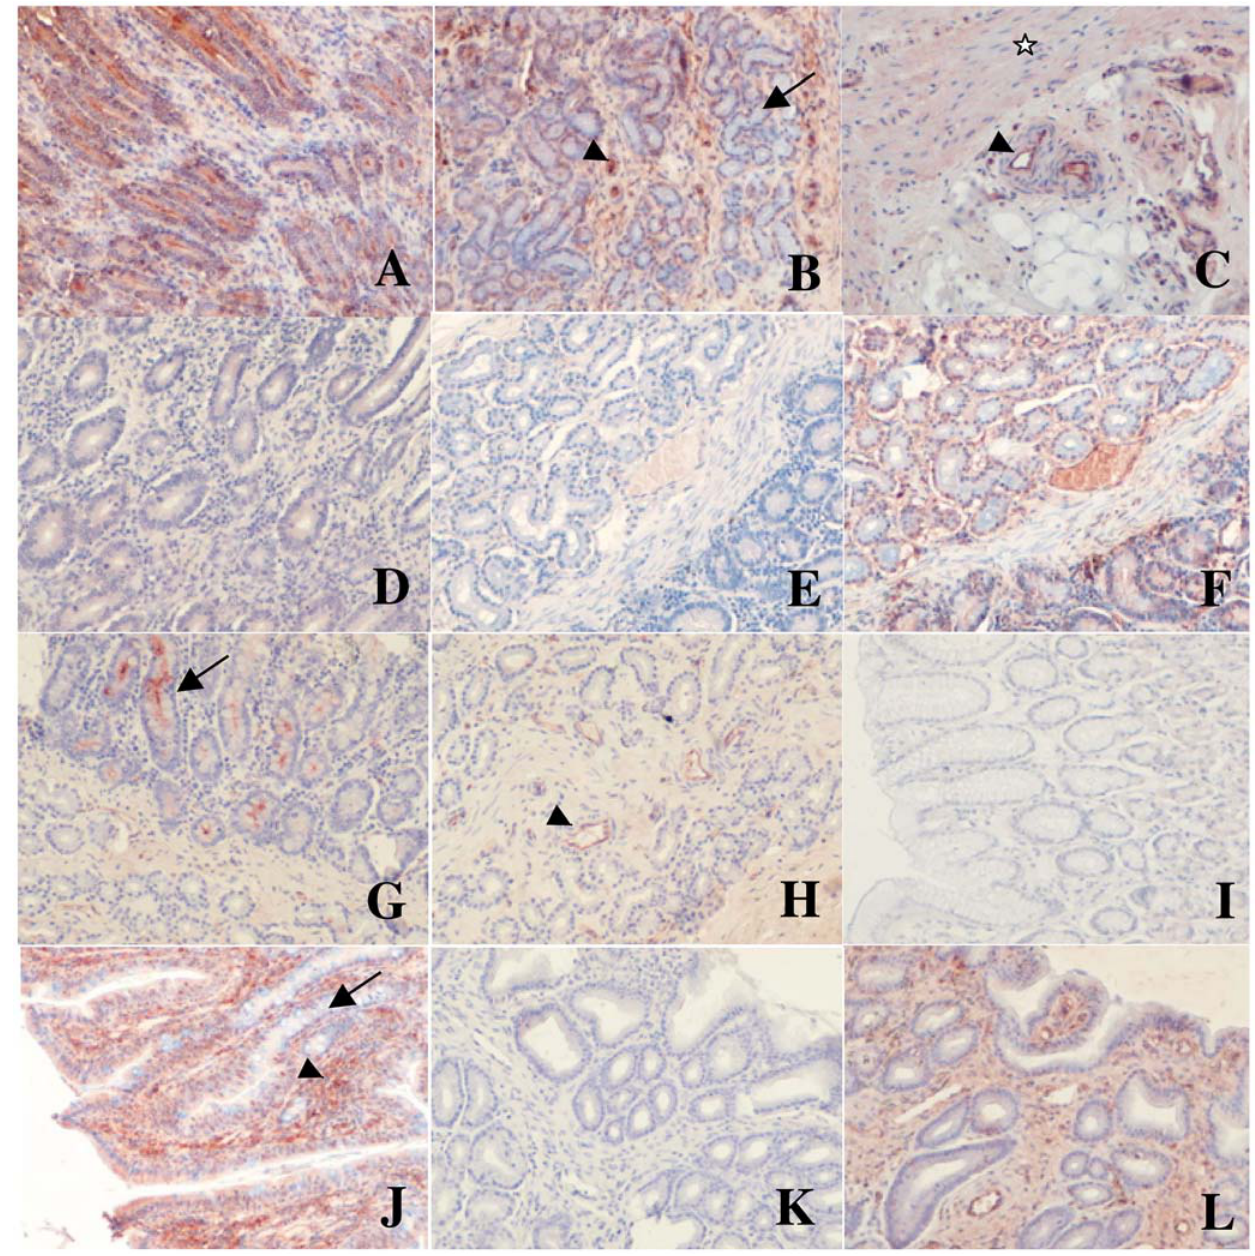
Figure 1. Analysis of rNB2 VLPs binding and of their ligand expression by immunohistology. VLPs at 1 m g/ml were incubated on tissue sections and detected as described in the Materials and Methods section. Binding of rNB2 VLPs to bovine duodenum surface epithelium (A), glands (B), smooth muscle (C) and negative control in absence of rNB2 VLPs (D). Effect of a 10 mM sodium periodate treatment prior to VLPs incubation (E) and serial control section pretreated in the same conditions without periodate (F). Staining of the surface epithelium (G) and vascular endothelium in connective tissue (H) of bovine duodenum by an anti- a Gal mAb. Lack of binding of rNB2 VLPs on human duodenum (I). Binding of rNB2 VLPs to porcine duodenum (J). Effect of a –galactosidase treatment prior to rNB2 VLPs incubation on a porcine duodenum tissue section (K) and control section pretreated in the same conditions in absence of enzyme (L). Epithelial cells are indicated by arrows, vascular endothelium cells by small arrowheads, and smooth muscle cells by a